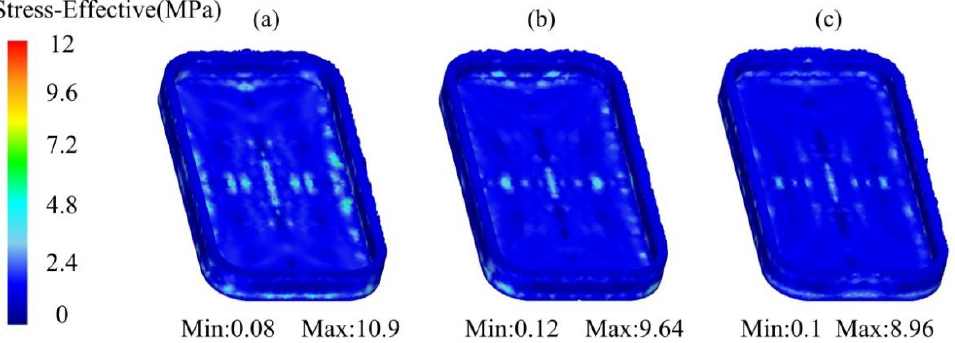
Figure 9. Equivalent stress distribution of the mobile shell processed by the thixotropic extrusion at the mould temperature of ( a ) 350 °C, ( b ) 400 °C, and ( c ) 450 °C.